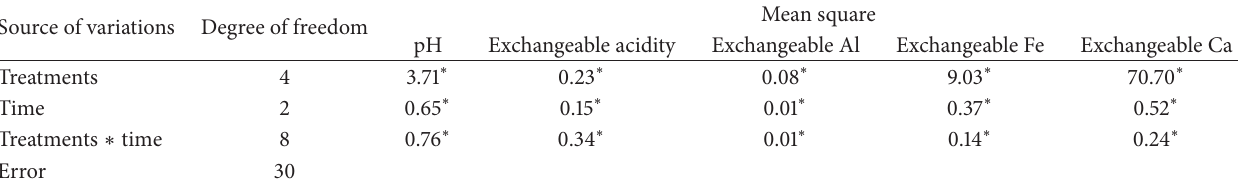
Table 3: Mean square values of analysis of variance (ANOVA) to evaluate the effects of treatments and time on the soil pH, exchangeable acidity, exchangeable Al, exchangeable Fe, and exchangeable